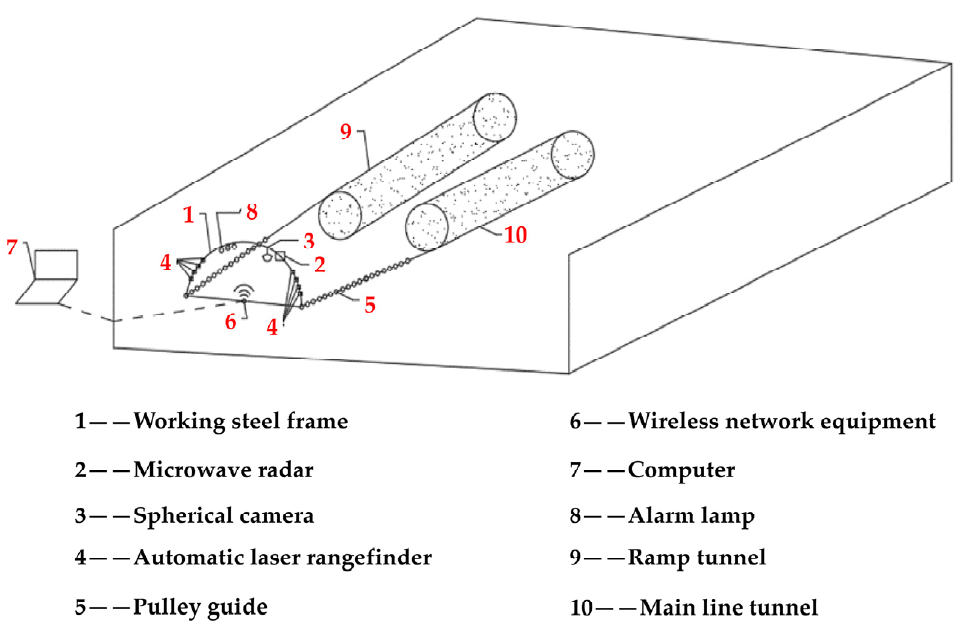
Figure 8. Automatic monitoring overall scheme layout.